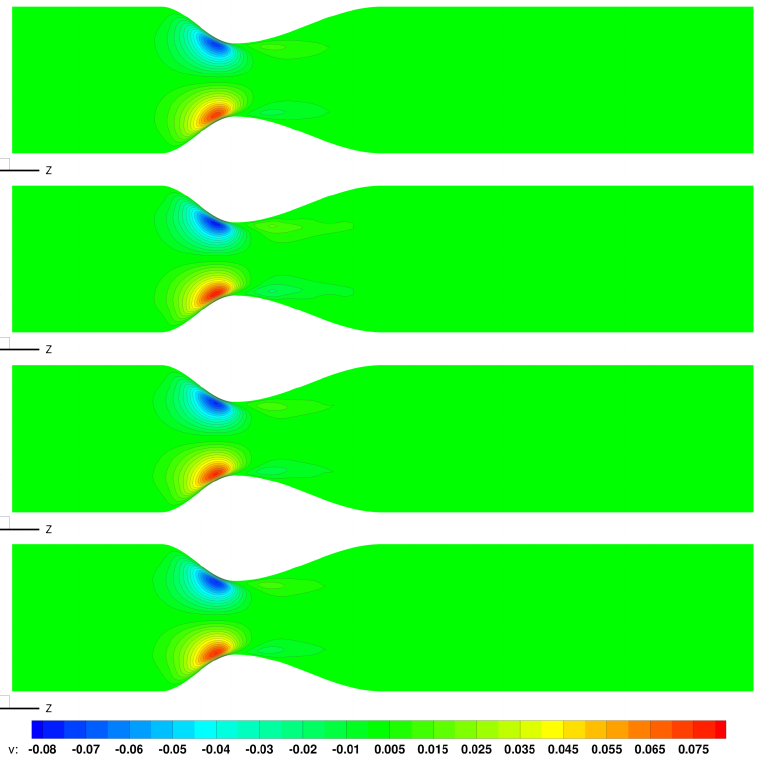
Figure 20. Radial velocity at flow rate Q = 2.0 cm 3 /s—GOB (top figure) and Johnson–Segalman models for a = − 0.9, a = − 0.8, a = − 0.7 (from the